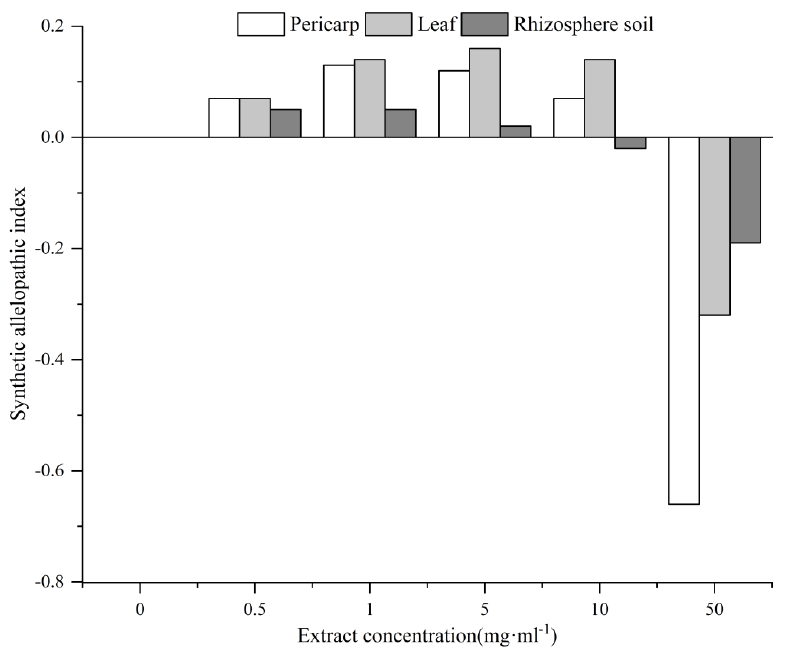
Figure 6. Allelopathic e ff ects of C. migao pericarp, leaf, and rhizosphere soil aqueous extracts at di ff erent concentrations on L. formosana